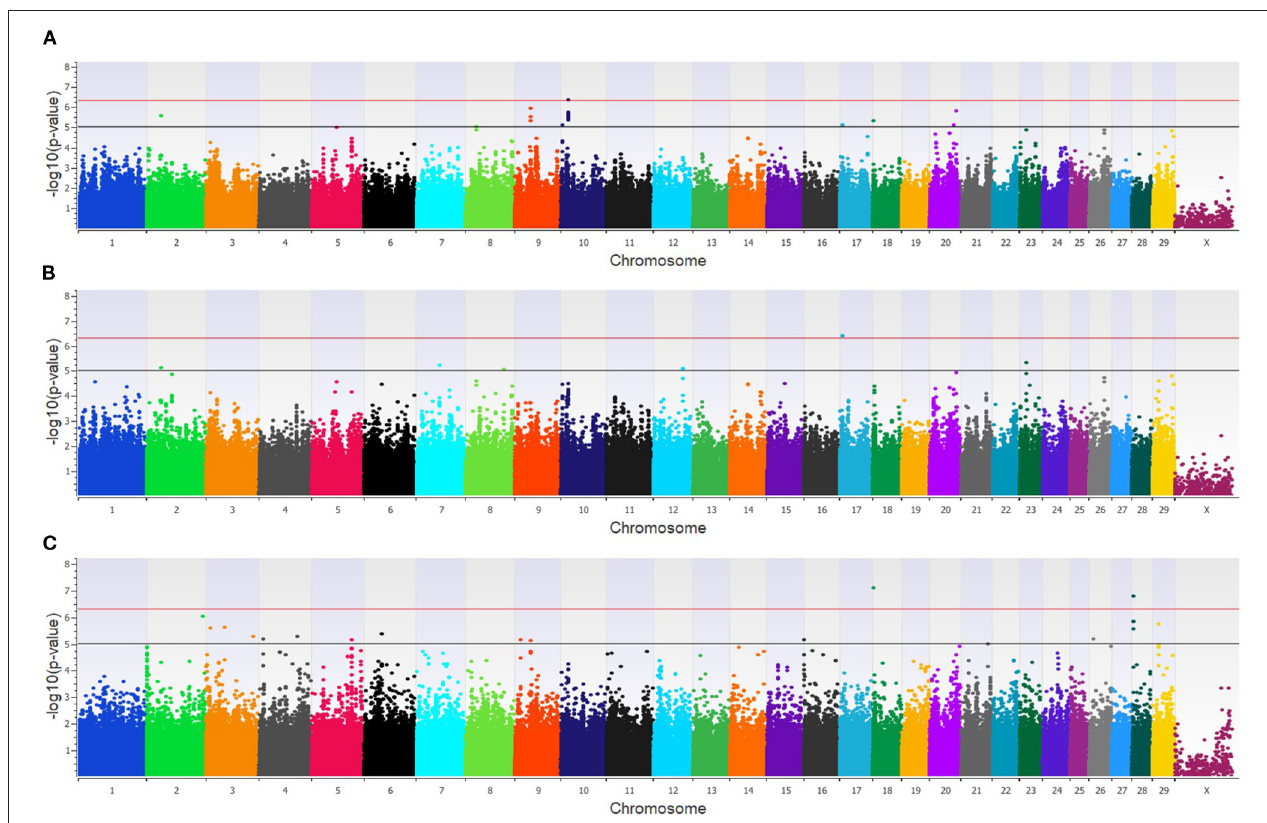
FIGURE 5 | Manhattan plots identifying loci associated with bovine coronavirus infection and bovine respiratory disease in additive (A) , dominant (B) , and recessive (C) EMMAX models for the feedlot population. Single-nucleotide polymorphisms (SNP) are represented by a single dot. Bovine chromosomes are listed on the x-axis. SNPs located between the black and red lines provide evidence of moderate association ( p between 1 × 10 − 5 and 5 × 10 − 7 ), and SNPs above the red line provide evidence of strong association ( p < 5 × 10 − 7 ) based on the Wellcome Trust Case Control Consortium (24)